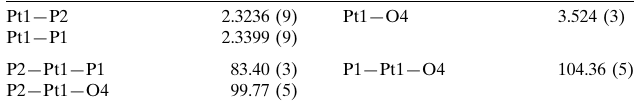
Selected geometric parameters (A˚ , (cid:2) ).